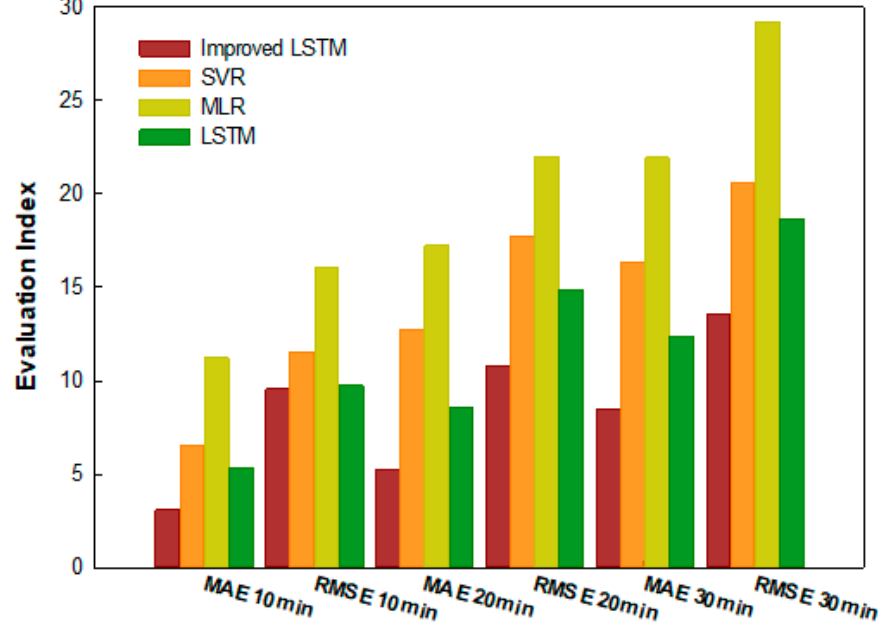
Figure 12. The average evaluation results of all parking lots for 10 min, 20 min, and 30 min.